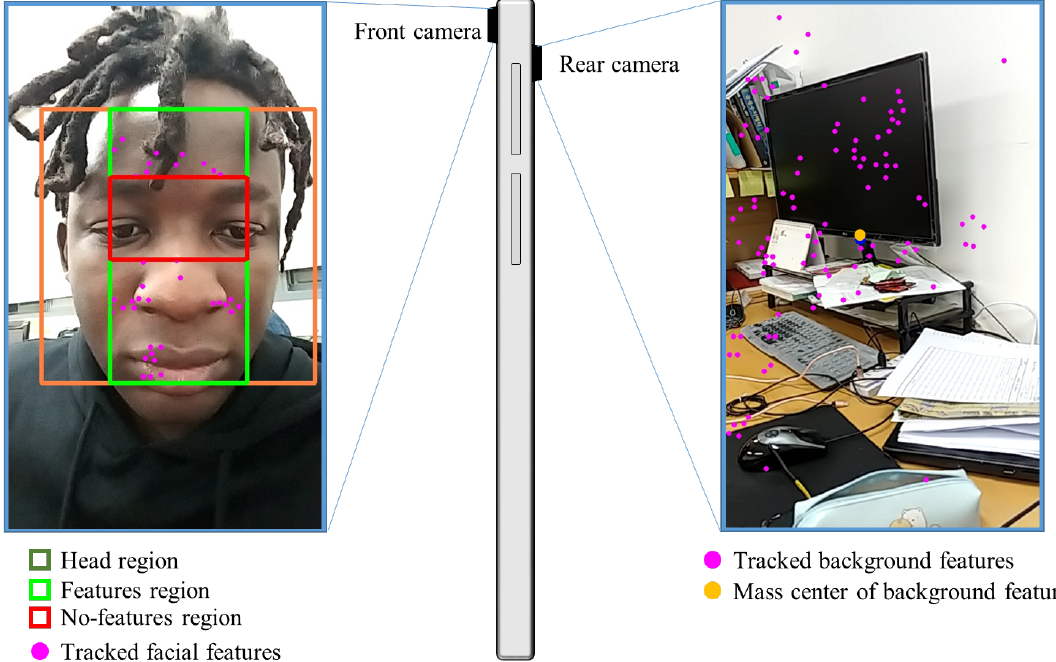
Figure 4. Facial and background features extracted using front and rear cameras, respectively, in portrait